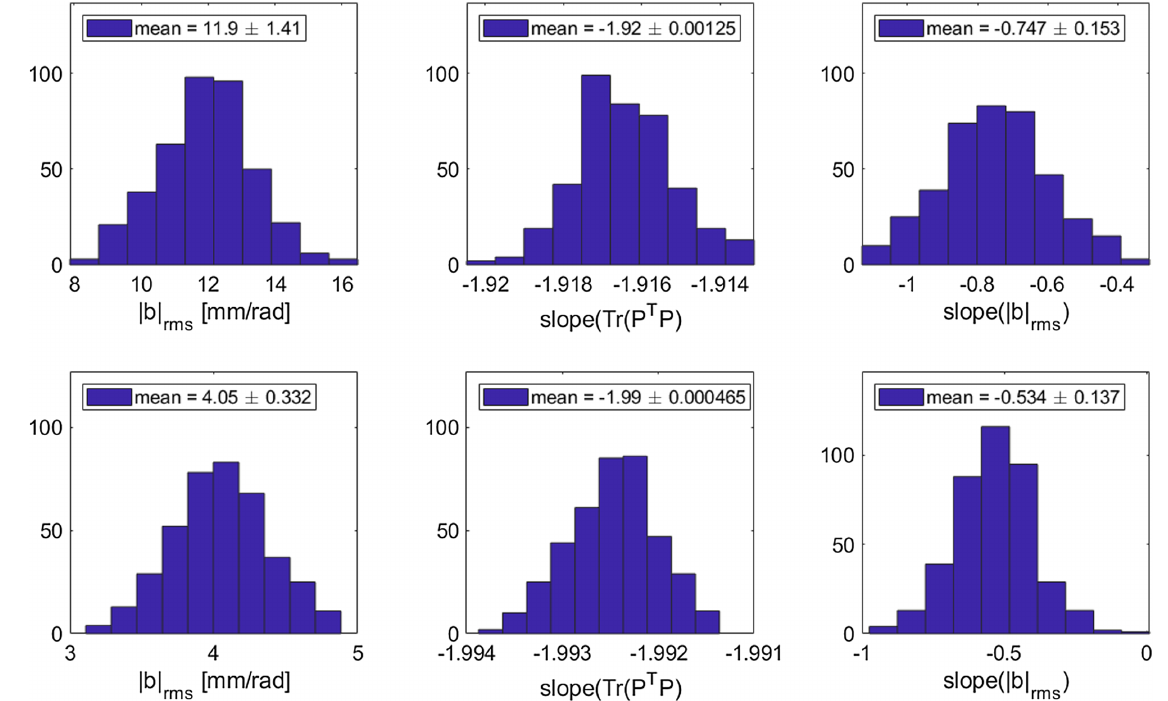
FIG. 11. Top row: histograms of the final discrepancy j b f j rms after 5 × 10 6 iterations (left) with σ w ¼ 0 . 1 mm, the slope of Trace ð P ⊤ T P T Þ (center) and the slope of j b T j rms (right) in the range 2 . 5 × 10 6 to 5 × 10 6 iterations. Bottom row: the corresponding plots with 20 μ rad round-robin dither